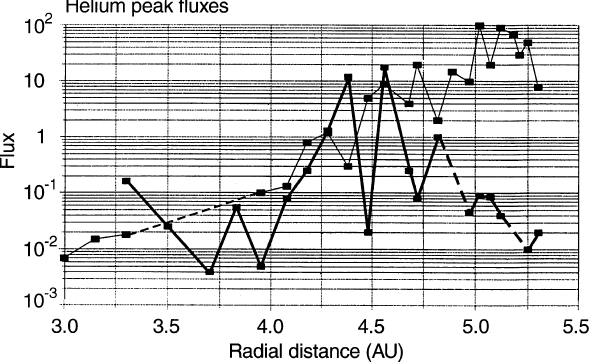
Fig. 4. Peak fluxes of energetic helium ions plotted versus radial distance from the Sun. Thin lines , inbound; thick lines ,